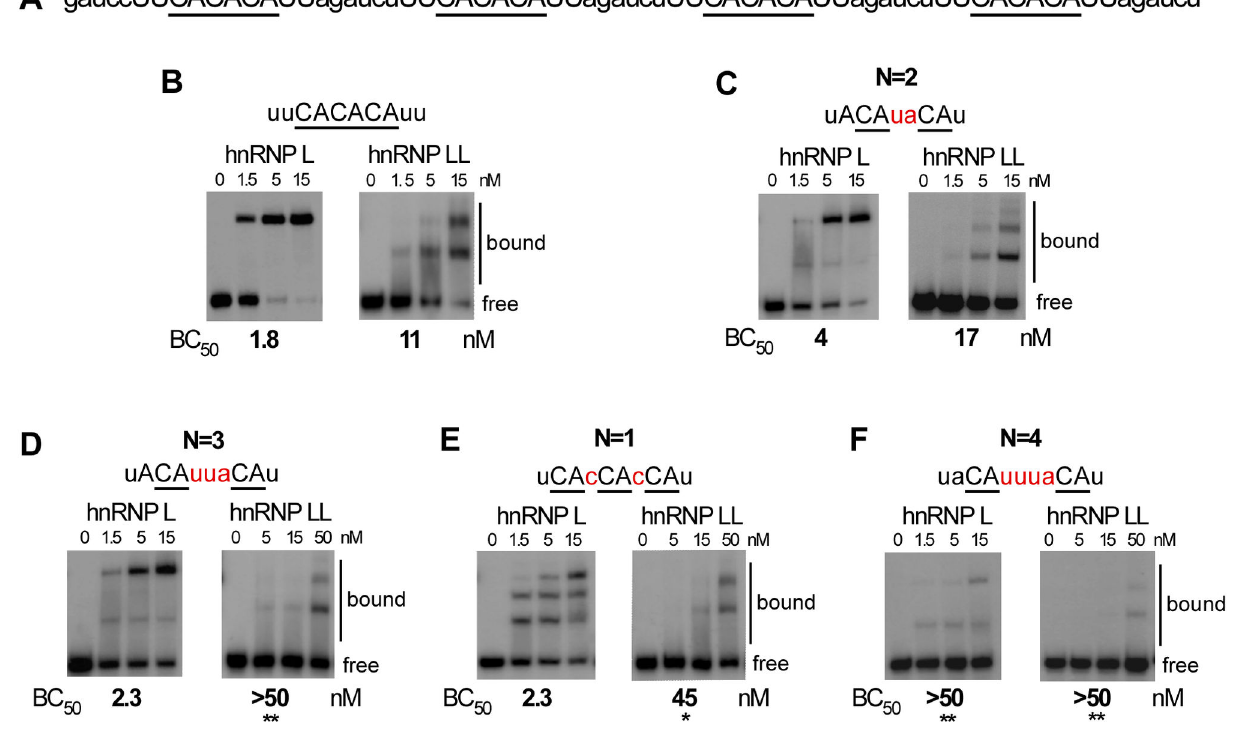
Figure 3. Binding of hnRNP LL is more sensitive than hnRNP L to spacing of CA dinucleotides. (A) Complete sequence used for binding in panel B and as backbone for experiments in Figure 3 and 5. (B-F) Representative native gel analysis (EMSA) of purified, recombinant GST-tagged hnRNP L or Flag-tagged hnRNP LL incubated with radiolabeled T7-transcribed RNAs corresponding to a variant of the sequence in panel A. For each panel the sequence shown was substituted at the capitalized positions in panel A. CA dinucleotides are underlined, for panels C-F spacers between CAs are in red (N=spacer #). Affinities (Concentration of 50% binding = BC ) from at least three independent replicates of the EMSAs are shown below gels. Bound and 50 free probe is indicated to the right of each gel. Asterisks indicate BC s which are significantly different from CACACA (*p<0.05, 50 **p<0.01), as calculated by a unpaired t-test between binding values determined from a minimum of three independent protein